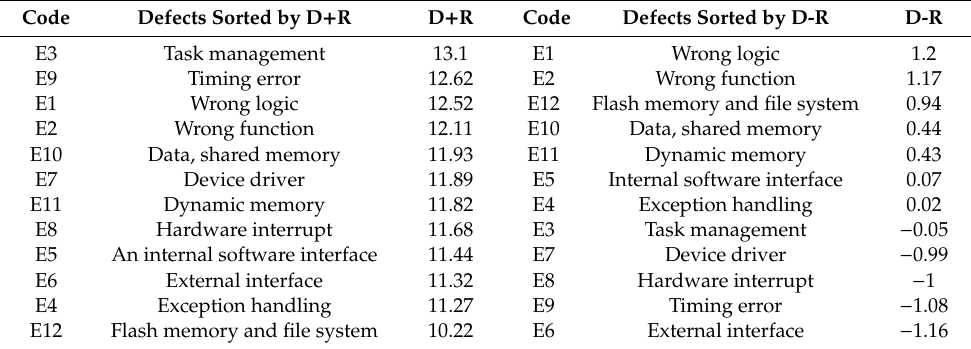
Table 13. Embedded software defects sorted with D + R and D-R.